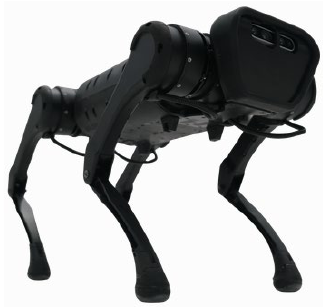
Figure 1. Unitree A1 robot.